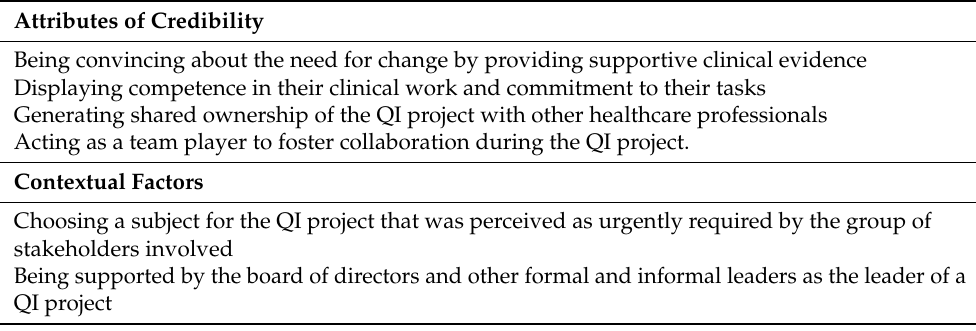
Table 2. Summary of